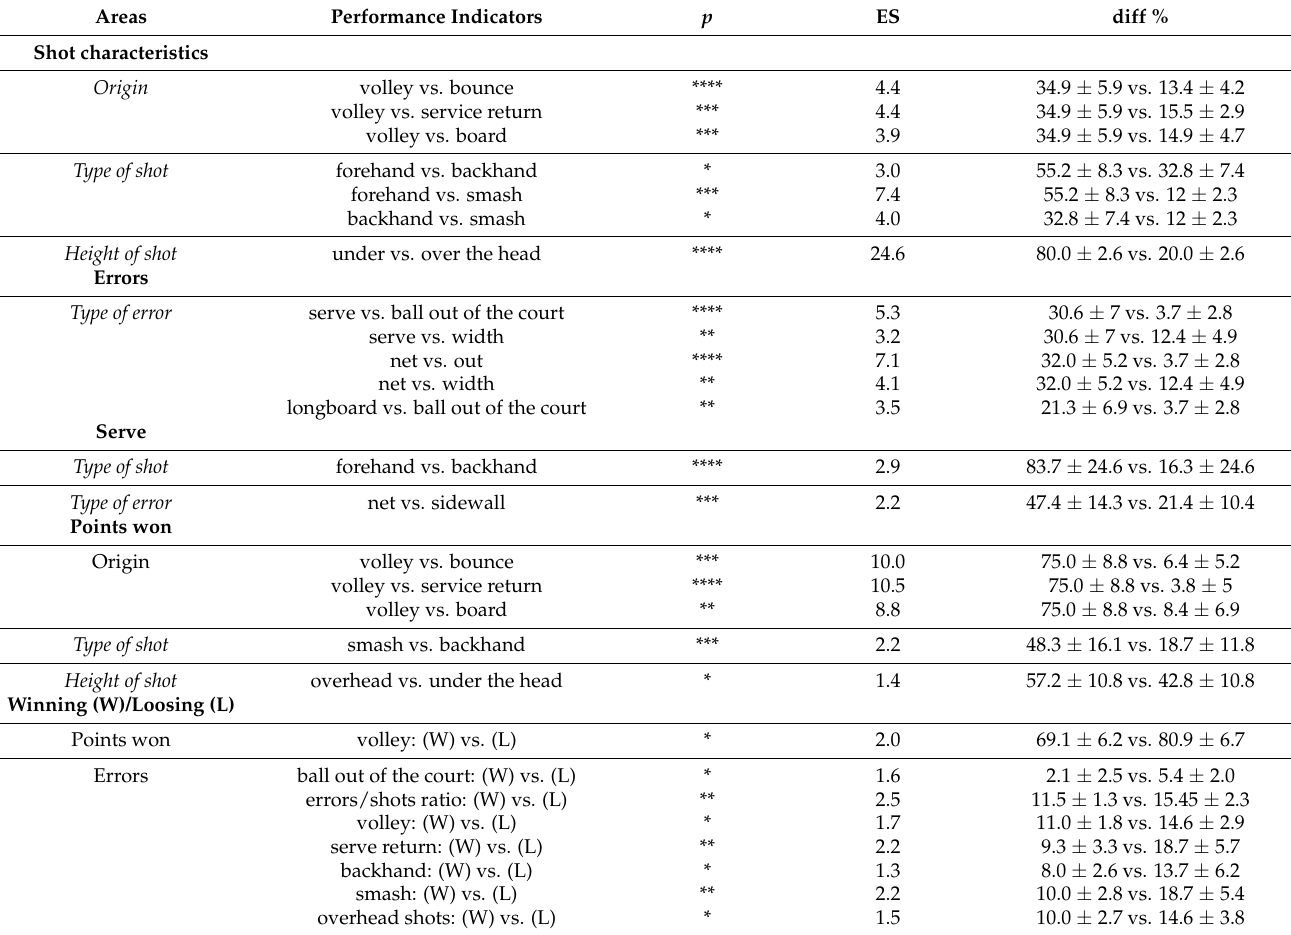
Table 2. Results of the inferential statistics applied to the notational analysis